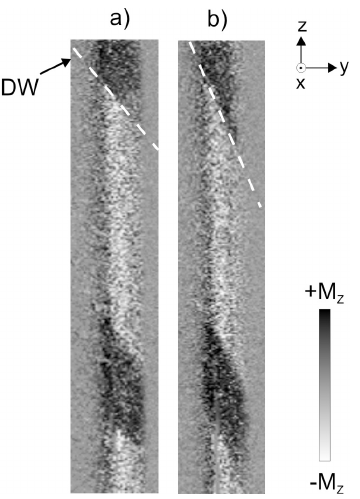
Figure 3. MOKE images of surface magnetic domains. Torsion strain 2 π radm − 1 . Amplitude of circular magnetic field with amplitude: ( a ) 0, ( b ) 7 A/m. White line shows the inclination of domain walls. Reprinted with permission from [15].